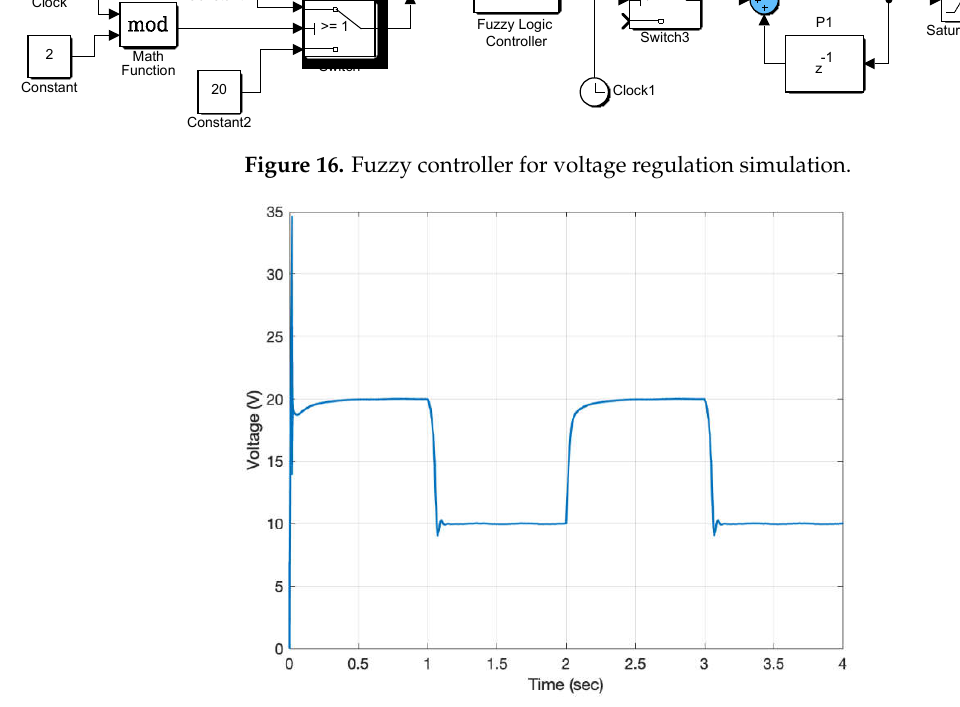
Figure 17. Simulation results for voltage regulation.